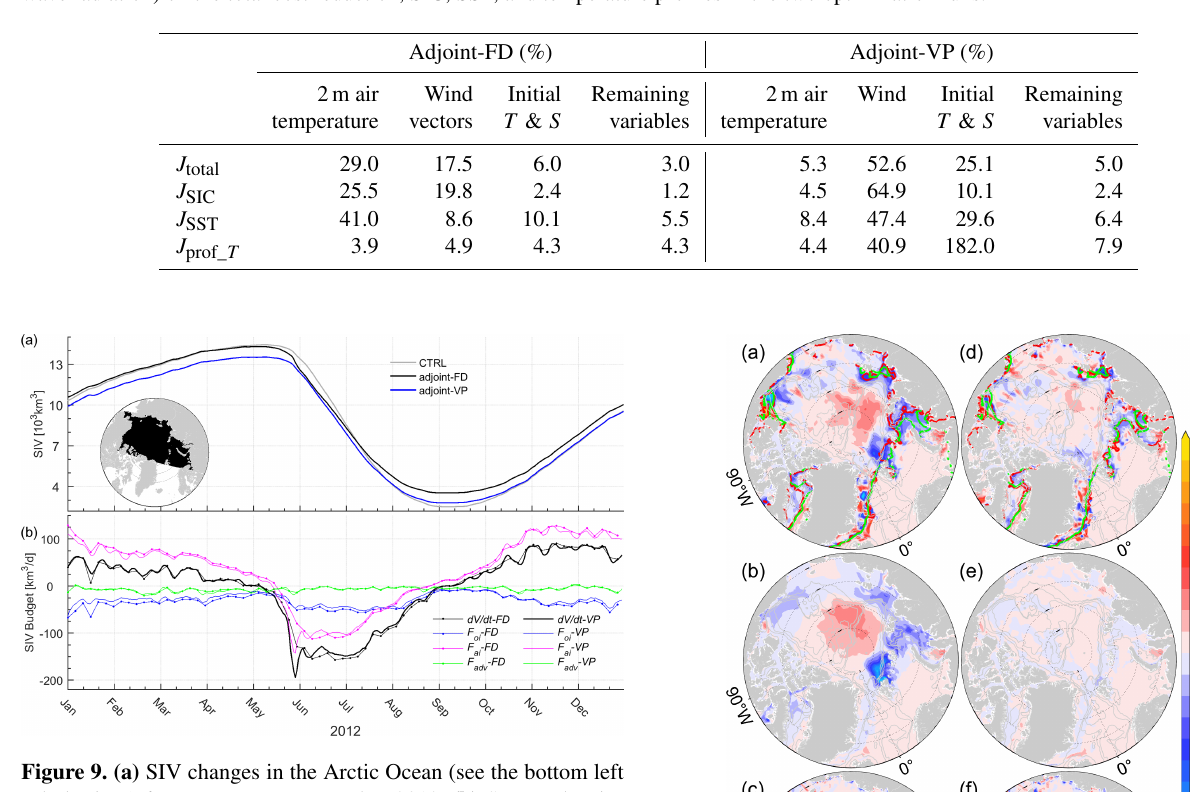
Table 3. Contributions of the adjustments of 2m air temperature, wind vectors, initial temperature and salinity (initial T & S ), and the remaining control variables (including initial mean SIT and SIC, 2m specific humanity, precipitation, downwelling longwave, and net short- wave radiation) on the total cost reduction, SIC, SST, and temperature profiles in the two optimization runs.